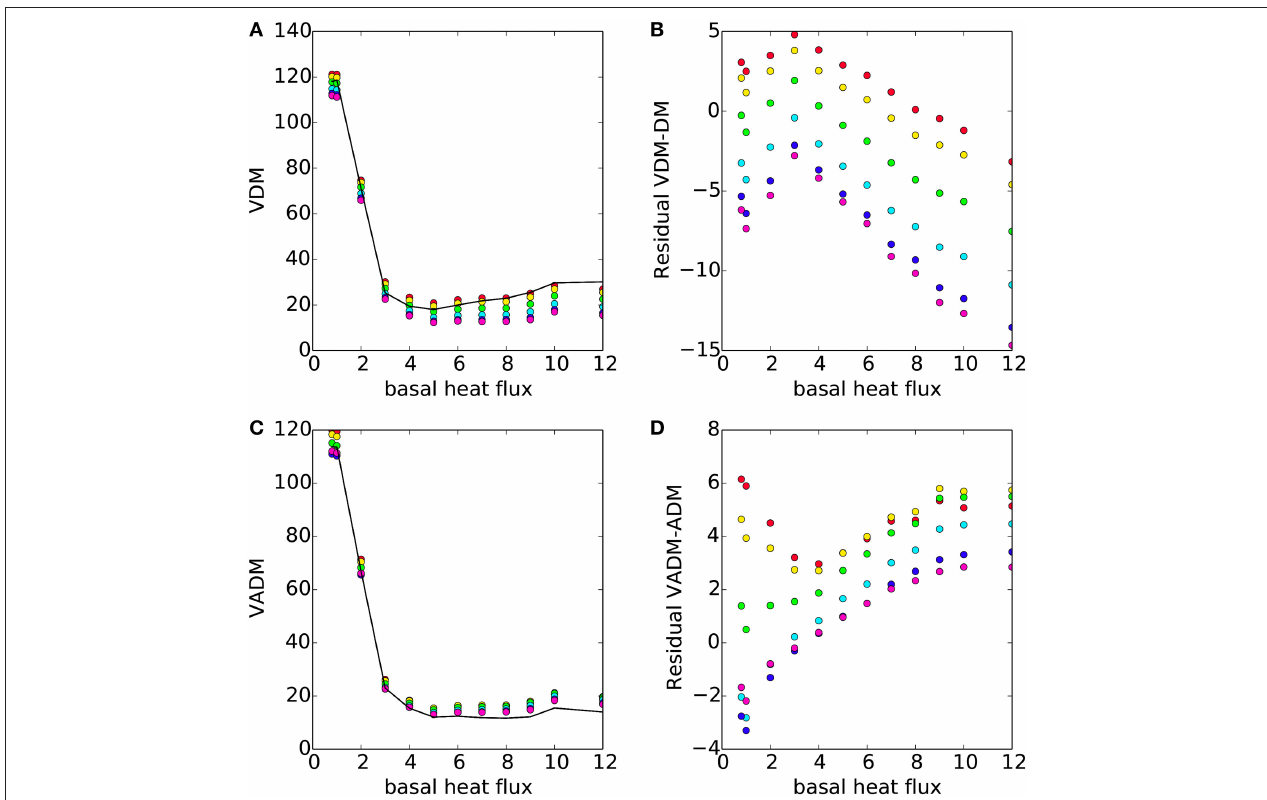
FIGURE 9 | (A) Synthetic observations of P VDM (filled circles) from (15) compared to the true P DM (black line) from (13). Colors refer to the same site co-latitudes as in Figure 7 . (B) Residual between observed P VDM and true P DM . (C,D) are the same as (A,B) for P VADM from (16) and P ADM from (14).